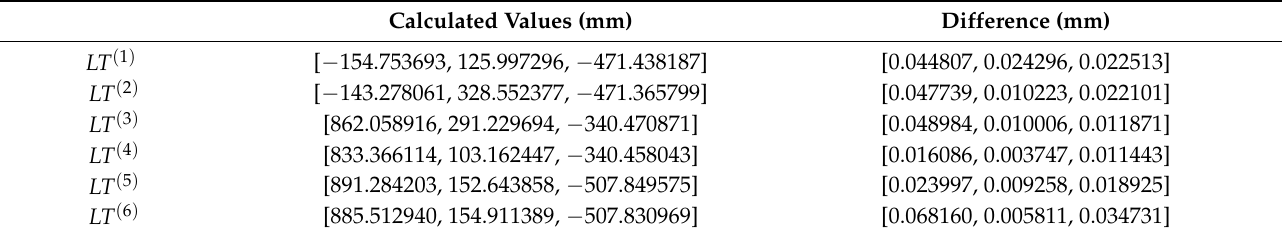
Table 8. Calculated LT positions for Case